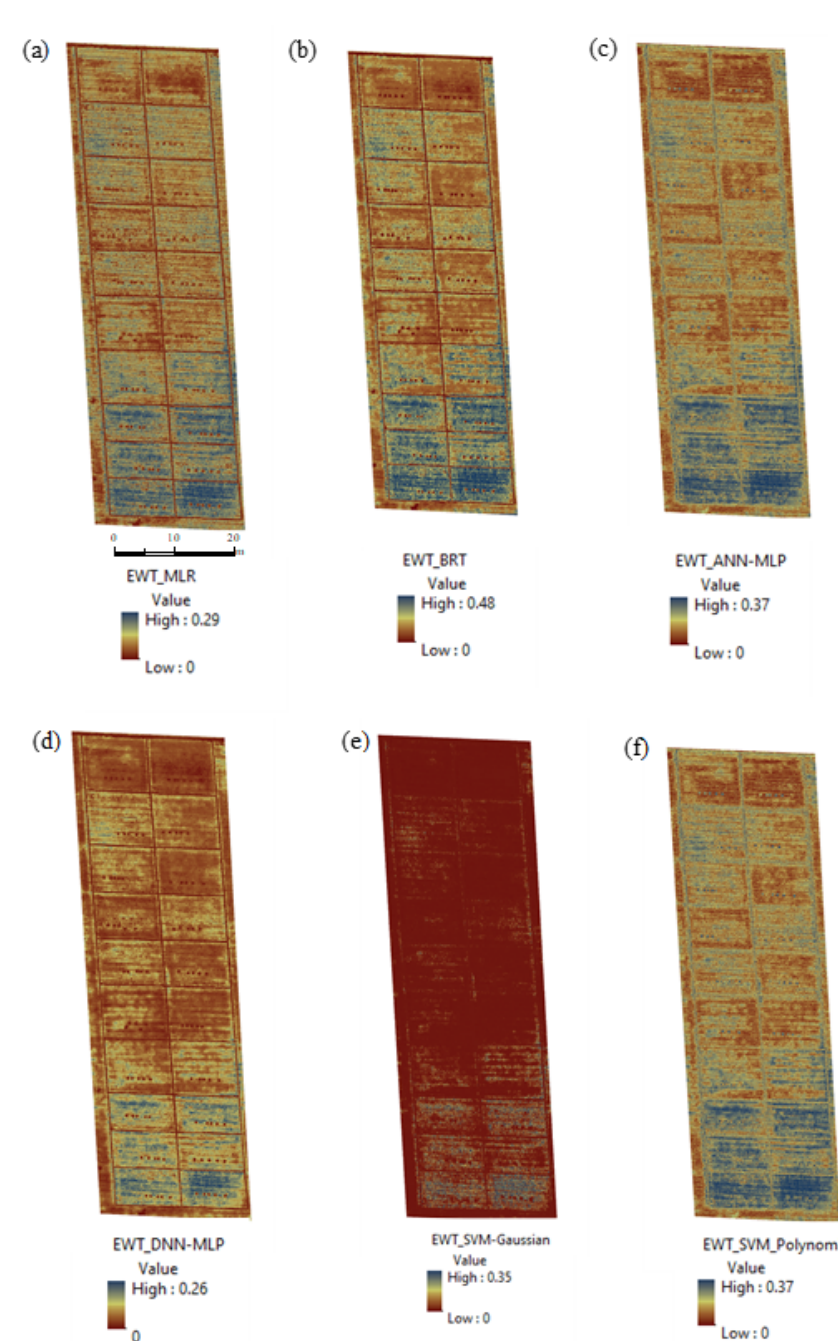
Figure 10. 𝐸𝑊𝑇 (cid:3030)(cid:3028)(cid:3041)(cid:3042)(cid:3043)(cid:3052) map used in field experiments at the anthesis stage via multiple linear re- gression (MLR, a ), boosted regression tree (BRT, b ), artificial neural network (ANN, c ), deep neural network (DNN, d ), support vector machine Gaussian (SVM-Gaussian, e ), and support vector machine polynomial (SVM-Polynomial, f ) models.